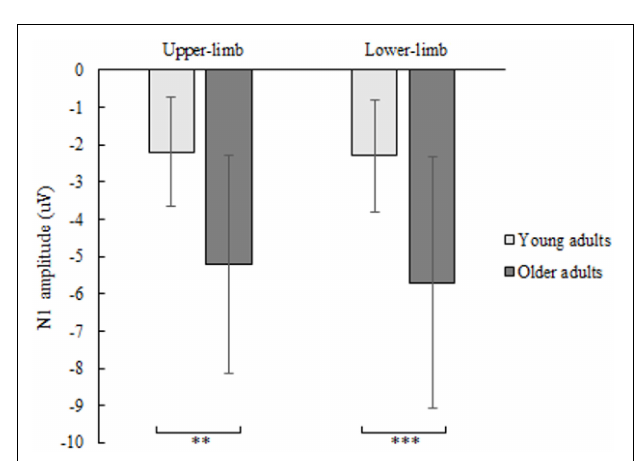
FIGURE 4 | N1 amplitude of younger and older adults for lower- and upper-limb conditions. Error bars reflect one SD. ∗ represents p < 0.05; ∗∗ represents p < 0.01; ∗∗∗ represents p <